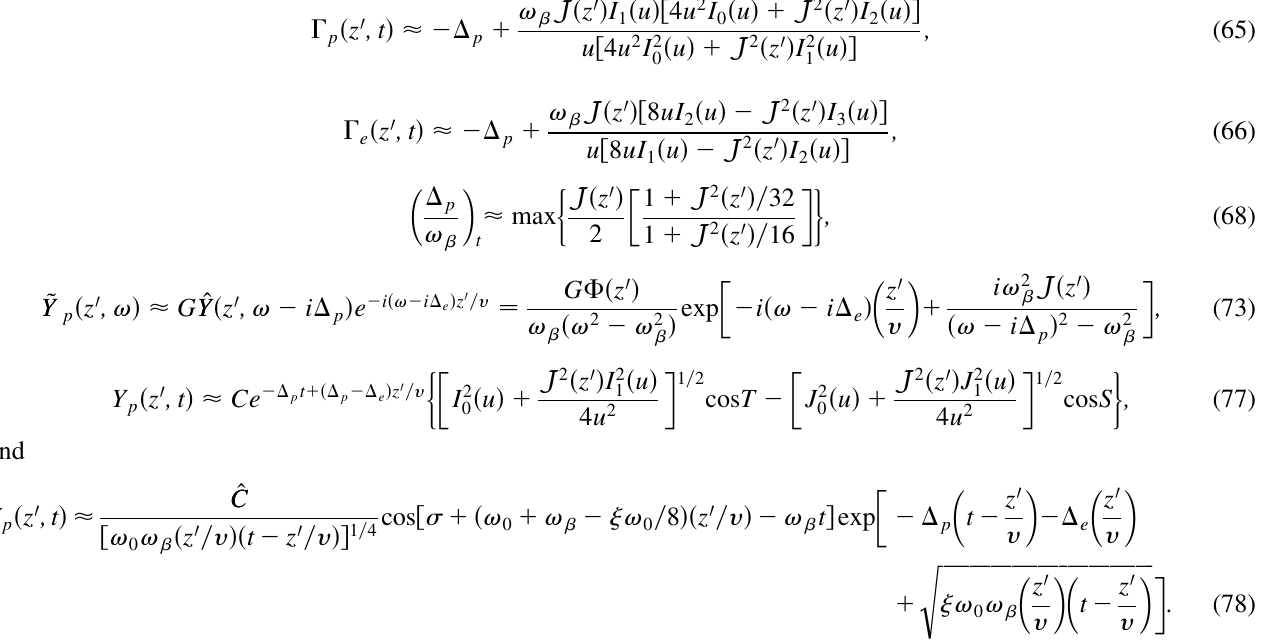
. The solid curve and the dashed curve are computed according to (cid:18)